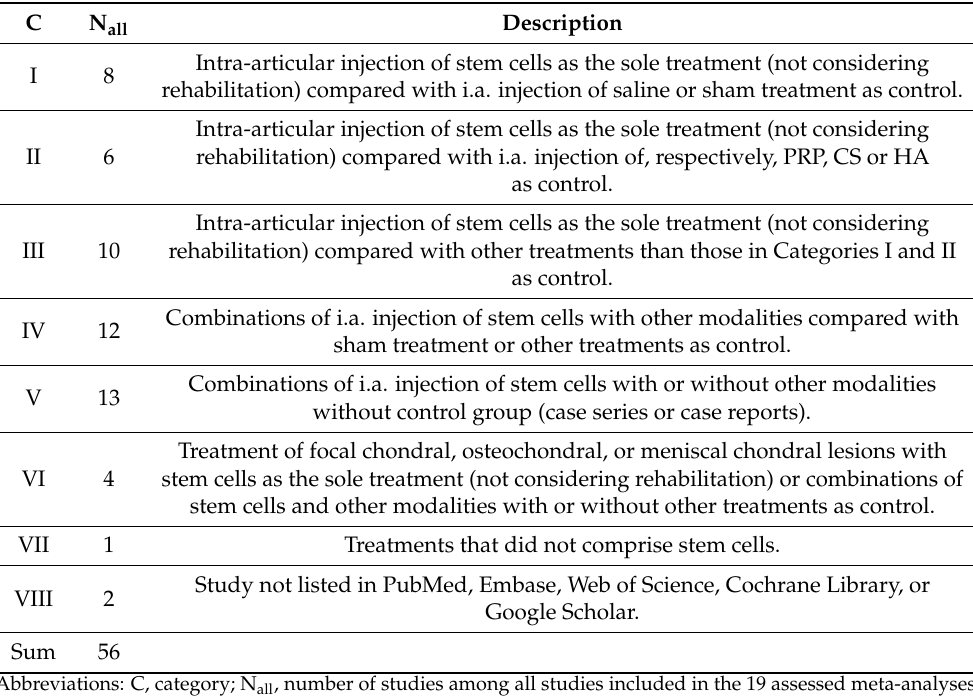
Table 1. Categories of studies included in the 19 meta-analyses summarized in Table S2, which details clinical studies in which management of primary knee osteoarthritis with stem cells was investigated.